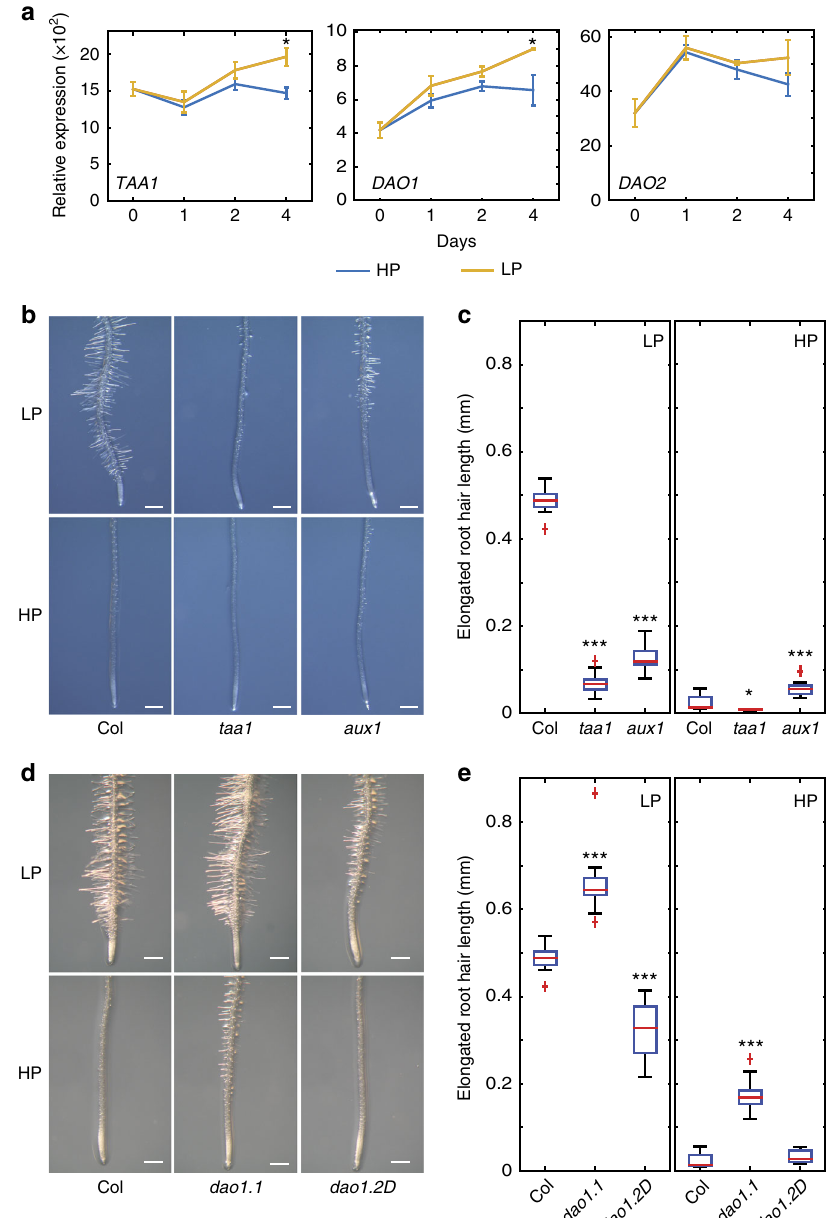
Fig. 2 Auxin homeostasis is crucial for root hair elongation under low P. a Genes regulating Auxin biosynthesis ( TAA1 ) and auxin degradation ( DAO1 , DAO2 ) are upregulated under low P (LP) conditions. *Indicate signi fi cant difference ( q -value < 0.0001) judged by Student ’ s t -test and after Benjamini and Hochberg false discovery rate correction. b , c Representative images ( b ) and boxplot ( c ) showing root hair length in the root hair zone under low (LP) or high P (HP) in Columbia (Col), aux1 (aux1-22) and taa1 mutant seedlings. N = 3, scale bar = 0.5 mm. *, **, and *** indicate signi fi cant difference ( q -value < 0.005, 0.0001 and 0.00001, respectively) judged by Student ’ s t -test. d , e Representative images ( d ) and boxplot ( e ) showing root hair length under low (LP) or high (HP) P in Columbia (Col) and dao1 (dao1 . 2 & dao1 . 2D) mutant seedlings. N = 3, scale bar 0.5 mm. *, **, and *** indicate signi fi cant difference ( q - value < 0.005, 0.0001, and 0.00001, respectively) judged by Student ’ s t